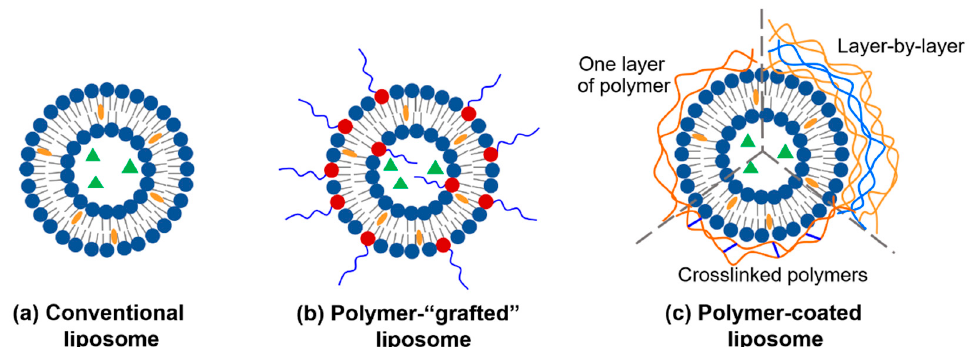
Figure 1. Liposomes for drug delivery: ( a ) conventional liposome, ( b ) polymer-“grafted” liposome, and ( c ) polymer-coated liposome, where liposomes are coated by a layer of adsorbed polymer, by the layer-by-layer (LbL) assembly, or by crosslinked polymers (polymer-“caged”). Liposomes can encapsulate hydrophobic drugs (orange ovals) in the hydrophobic region and hydrophilic ones (green triangles) in the interior aqueous region.